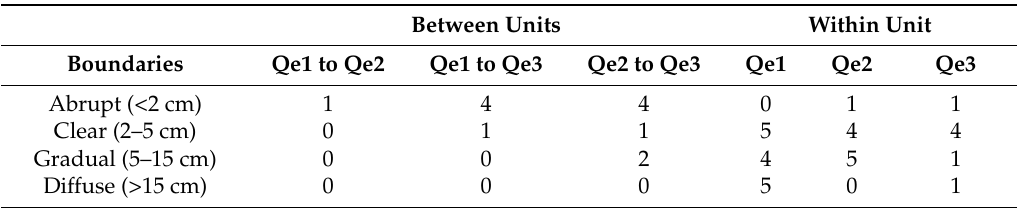
Table 7. Unit boundaries from table of soil profile descriptions. Boundary descriptions after Birkeland (1999) [34].